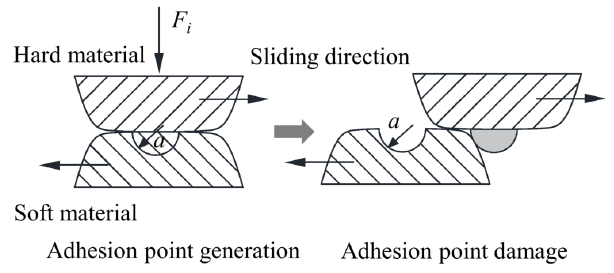
Figure 3. Archard adhesion wear theoretical